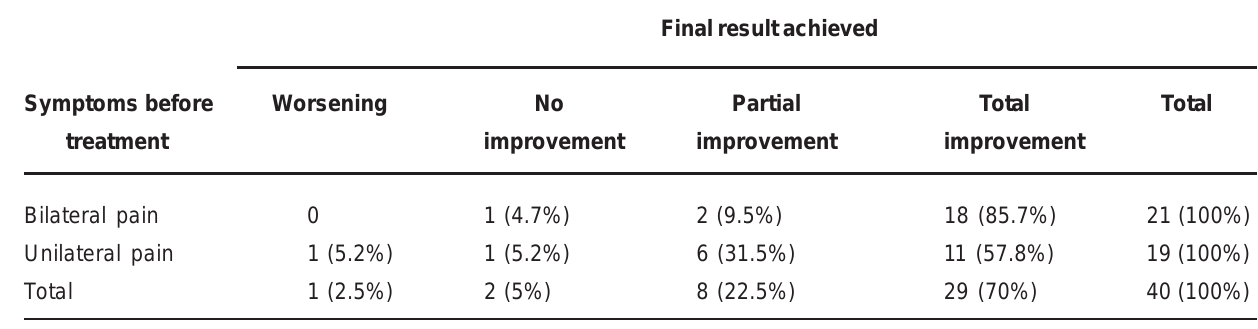
TABLE 1 - Distribution of the patients according to the symptoms presented before treatment and the final result in relation to the symptoms